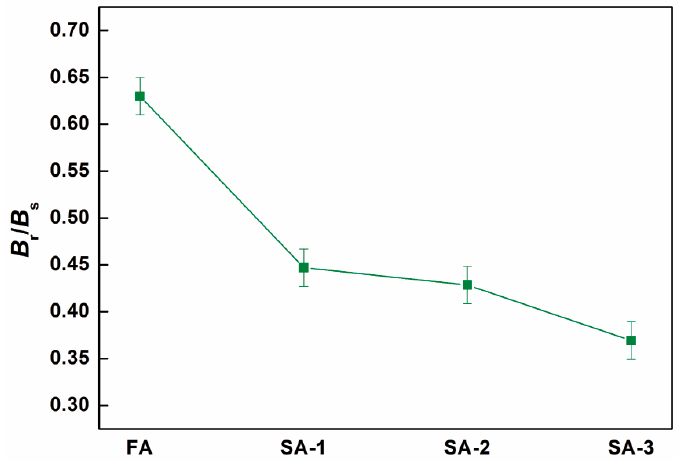
Figure 4. Squareness ratio ( B r / B s ) determined from DC hysteresis loops.